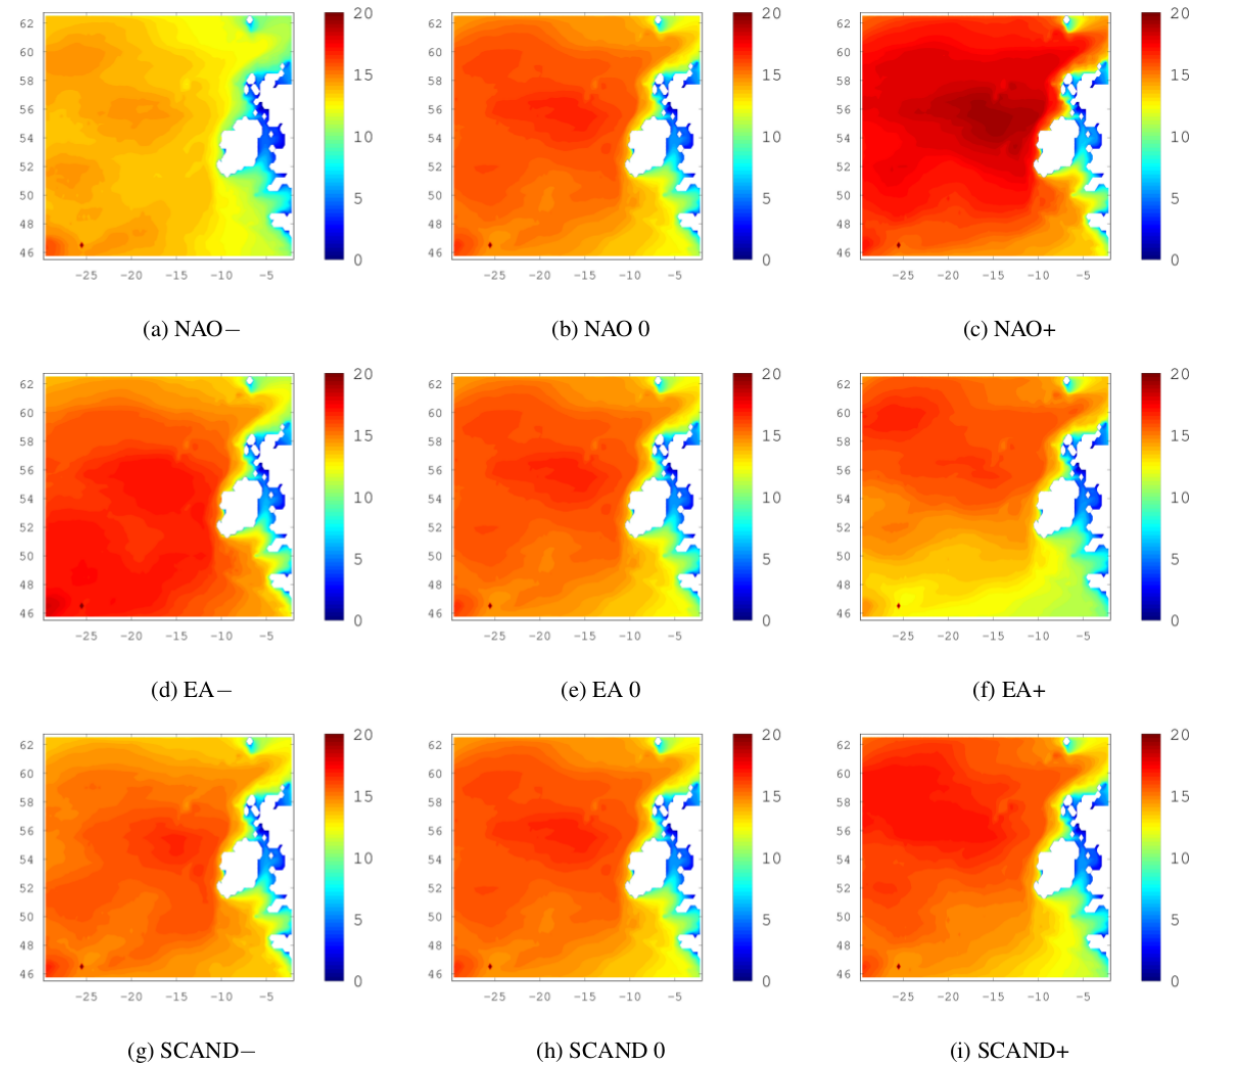
Figure 5. 20-year return levels of H s where the effects of the NAO, EA and SCAND are isolated by setting each of the remaining two indices to zero. The ensemble mean is shown for the historical simulations.